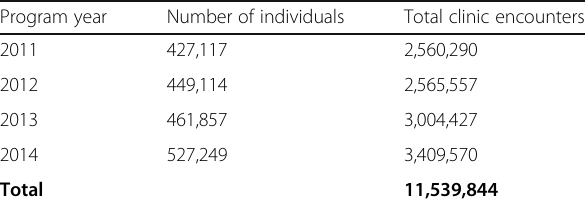
Table 1 Number of individuals and clinic encounters in HIV care, treatment, and support program in Tanzania from 2011